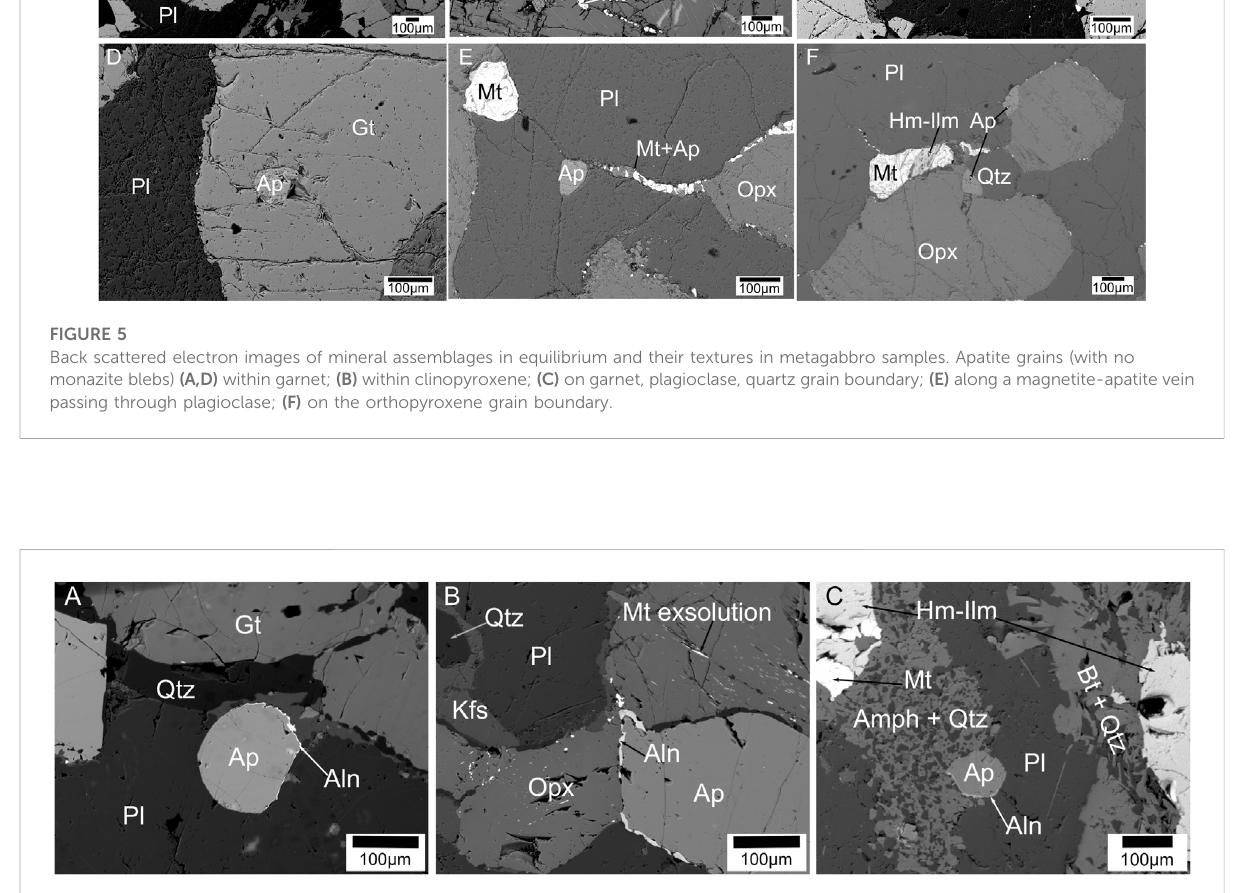
Back scattered electron images of allanite at apatite grain boundary. (A) allanite forming on apatite associated to plagioclase in charnockite sample; (B) allanite forming on apatite associated to orthorpyroxene in two-pyroxene granulite sample; (C) allanite forming on apatite associated to amphiboles in Hb-Bt gneiss